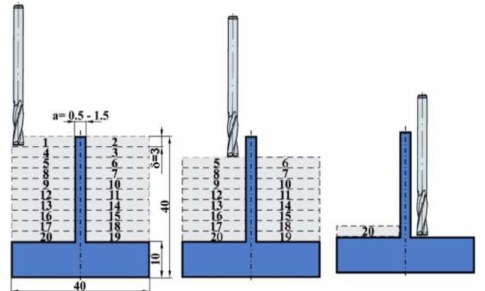
Figure 4. Selected machining passes sequence for the machining of thin-walled